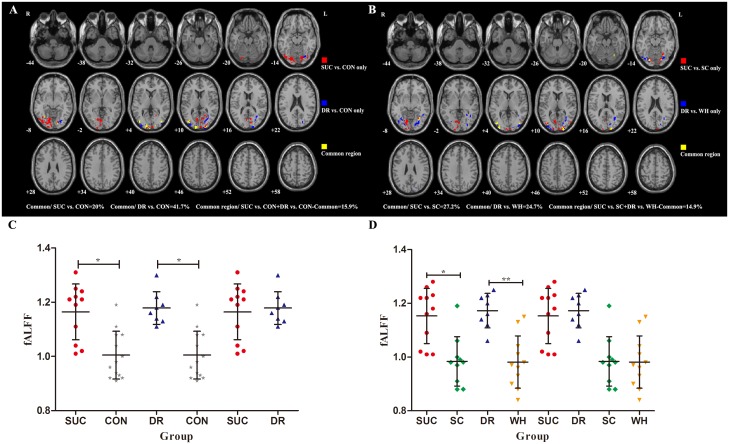
Spatial overlapping maps and scatter plots showing fALFF values of overlaps.
A: SUC vs. CON and DR vs. CON. Overlap regions account for 20% of SUC vs. controls, 41.7% of DR vs. controls, and 15.9% of total respectively. The yellow parts represents brain regions with common fALFF changes between SUC vs. controls and DR vs. controls including the bilateral lingual gyrus, cuneus, inferior occipital gyrus, middle occipital gyrus, right superior occipital gyrus, subcortical structure of left occipital lobe, subcortical structure of right temporal lobe, and left fusiform. The red parts show regions with fALFF differences from comparison of SUC vs. CON only. The blue parts show regions with fALFF differences from comparison of DR vs. CON only. B: SUC vs. SC and DR vs. WH. Overlap regions account for 27.2% of SUC vs. SC, 24.7% of DR vs. WH, and 14.9% of total respectively. The yellow parts represents brain regions with common fALFF changes between SUC vs. SC and DR vs. WH were found in the bilateral middle occipital gyrus, fusiform, lingual gyrus, the right superior occipital gyrus, cuneus and cerebellum posterior lobe. The red parts show regions with fALFF differences from comparison of SUC vs. SC only. The blue parts show regions with fALFF differences from comparison of DR vs. WH only. All comparisons were restrained in the ANOVA mask. C: fALFF values of overlap with common brain activity changes between SUC vs. CON and DR vs. CON. The error bar represents the standard deviation. * P< 0.001. D: fALFF values of overlap with common brain activity changes between SUC vs. SC and DR vs. WH. The error bar represents the standard deviation. * P = 0.001, * *P< 0.001.